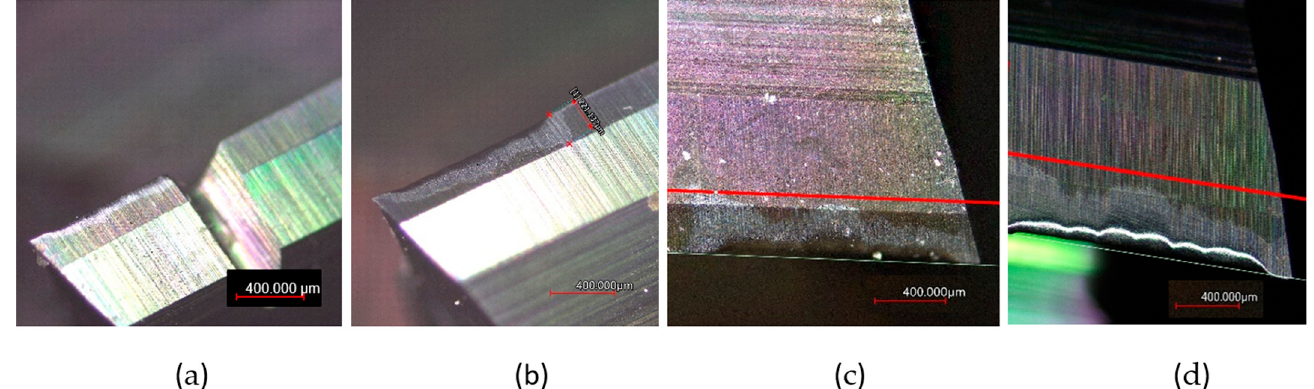
Figure 26. Tool wear of the ECSSF milling tool, laminate thickness 1 mm. ( a ) Tool tooth path 5 × 165 m; ( b ) tool tooth path 10 × 165 m; ( c ) tool tooth path 15 × 165 m; ( d) tool tooth path 20 × 165 m.